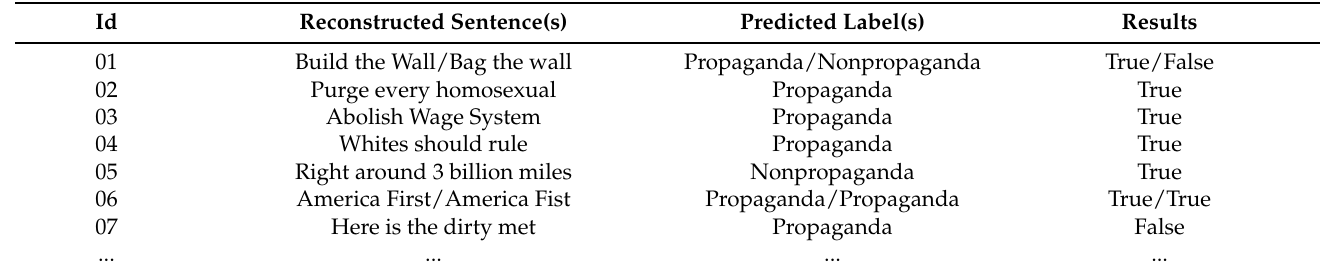
Table 9. Reconstructed sentences and related classification results.